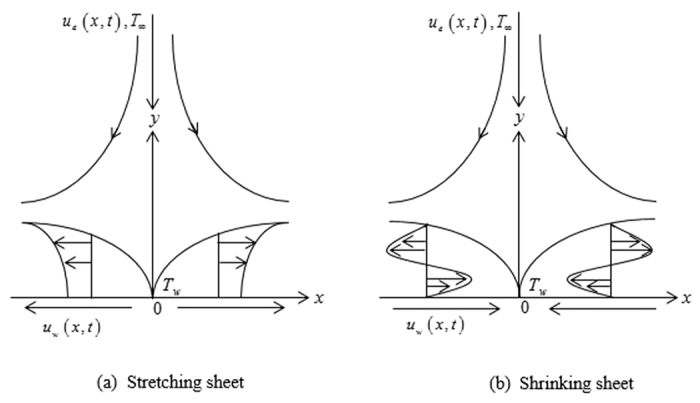
Physical model and coordinate system.